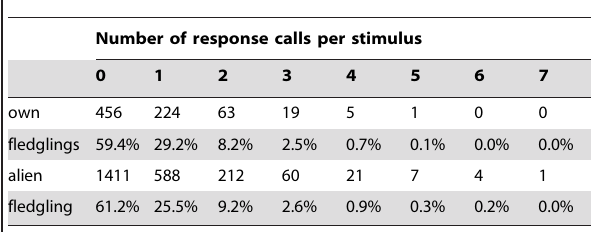
Table 2. Counts of how often adults responded with a certain number of calls to stimuli from own or alien fledglings and the according percentage of the overall response.